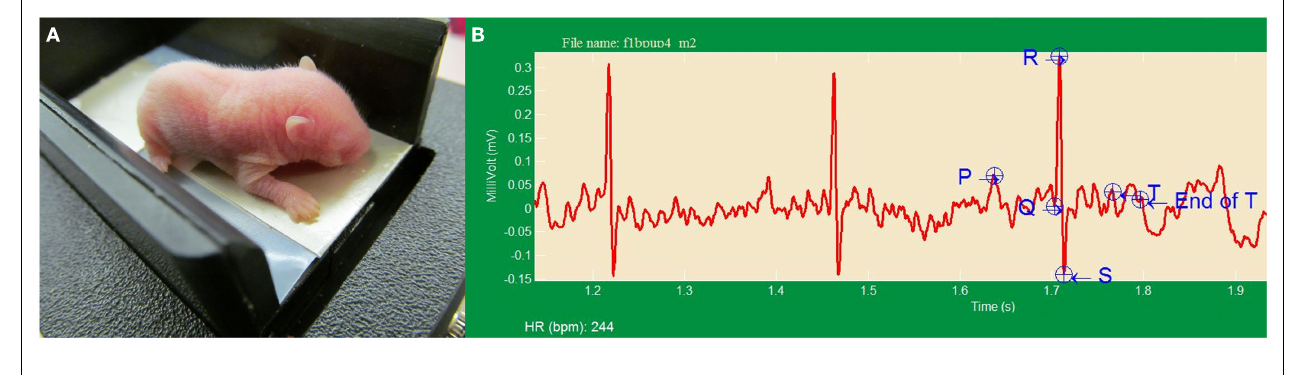
significantly higher, and heart rate variability significantly lower, inTO-2 dystrophic hamsters, indicative of autonomic dysfunction, beginning very early in